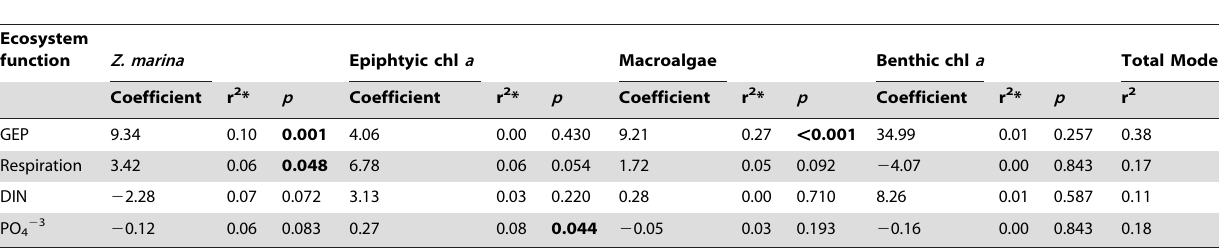
Table 2. Regression of daily ecosystem flux rates against biomass of the major primary producer groups. Ecosystem function